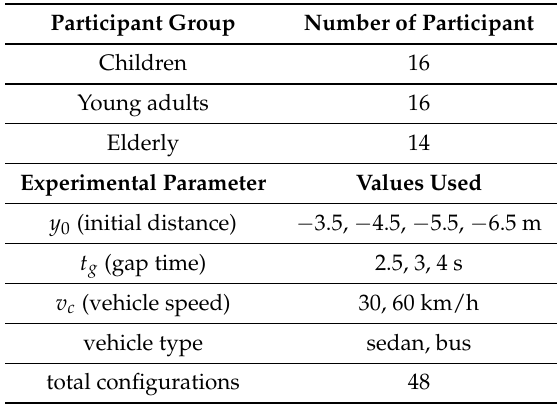
Table 1. Table summarizing age groups and experimental